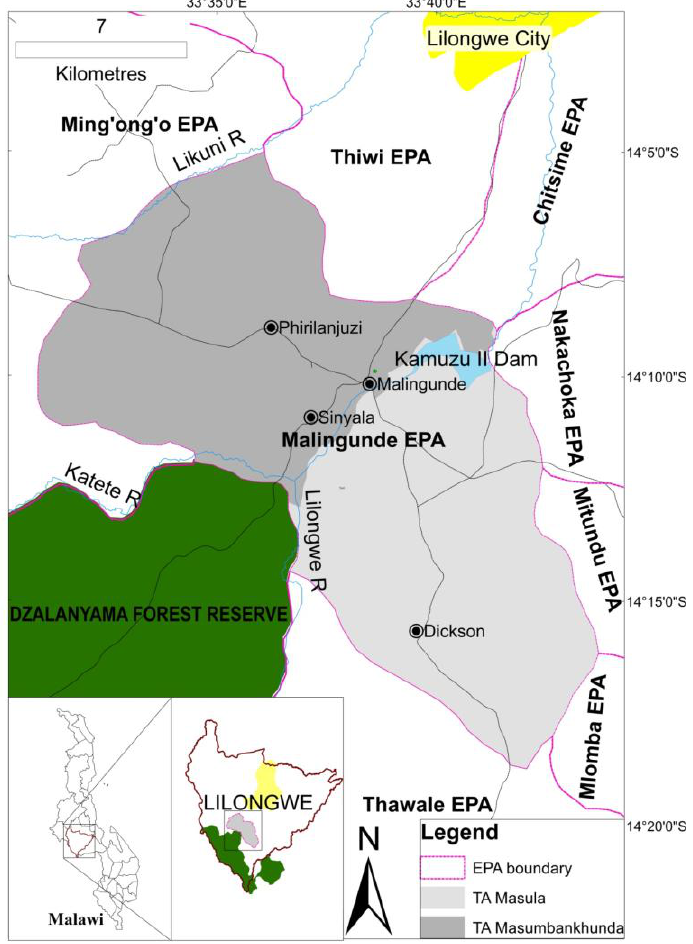
Figure 1. The study site: Malingunde Extension Planning Area (EPA), Lilongwe,